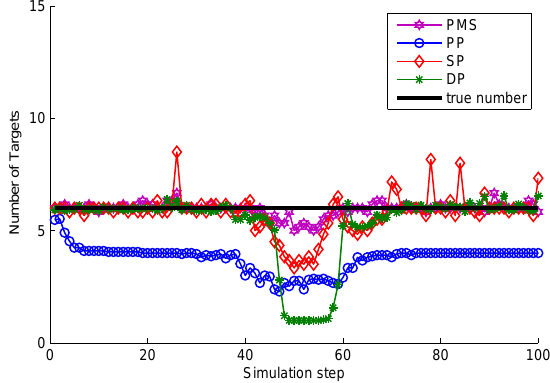
Figure 14. The comparison of four approaches in target number